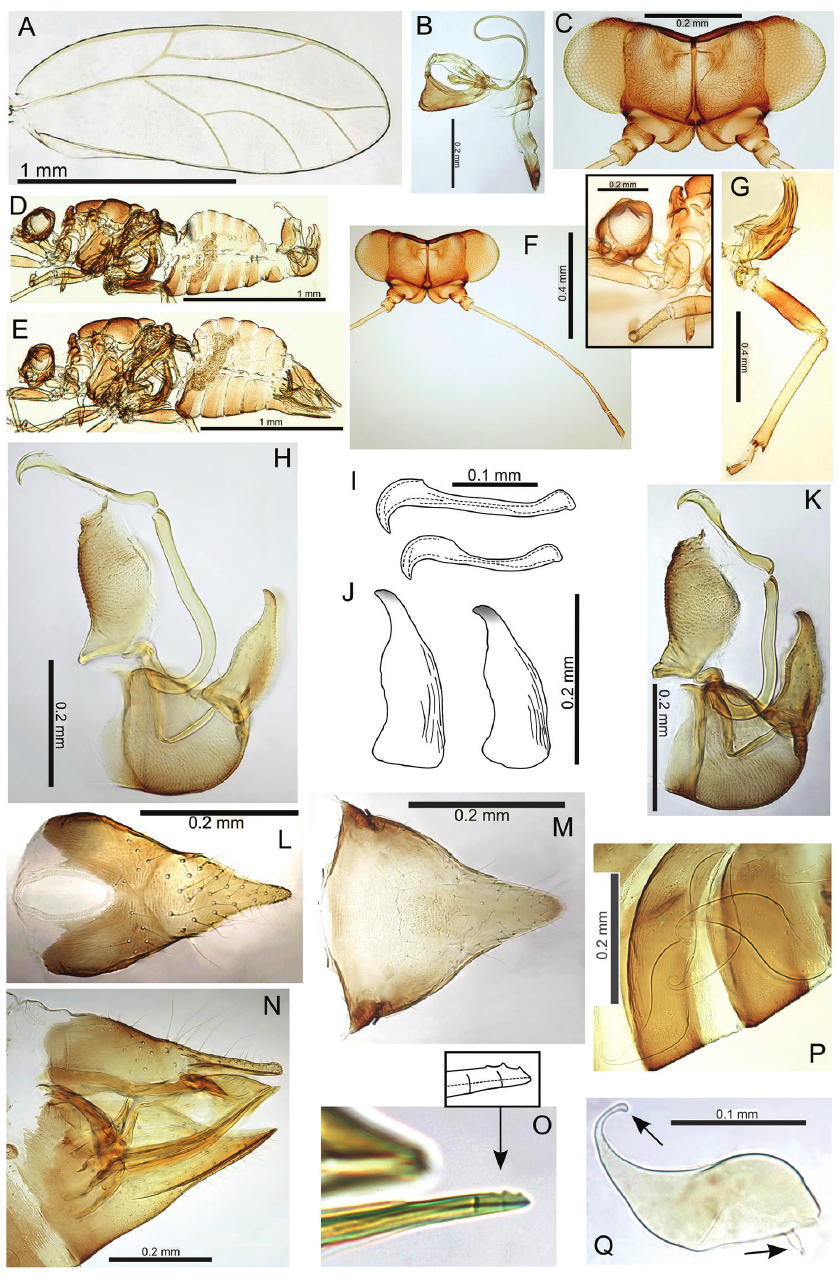
Figure 25. Pariaconus caulicalix sp. n. A fore wing B proboscis C head D male E female F head and antenna and head (lateral view, inset) G hind leg H male terminalia, form brunneis I aedeagi: form brun- neis (above), form rubrus (below) J parameres: form brunneis (left), form rubrus (right) K male terminalia, form rubrus L female proctiger (dorsal view) M female subgenital plate (ventral view) N female terminalia O ovipositor (serrations indicated) P, Q eggs (pedicel and tail